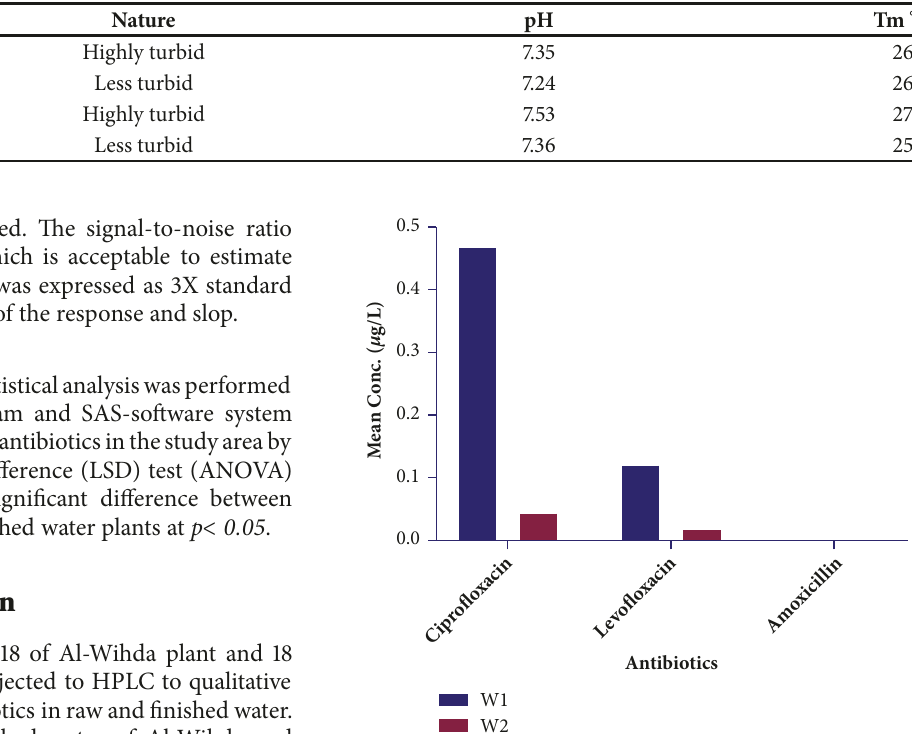
Table 1: Turbidity and pH values of samples.